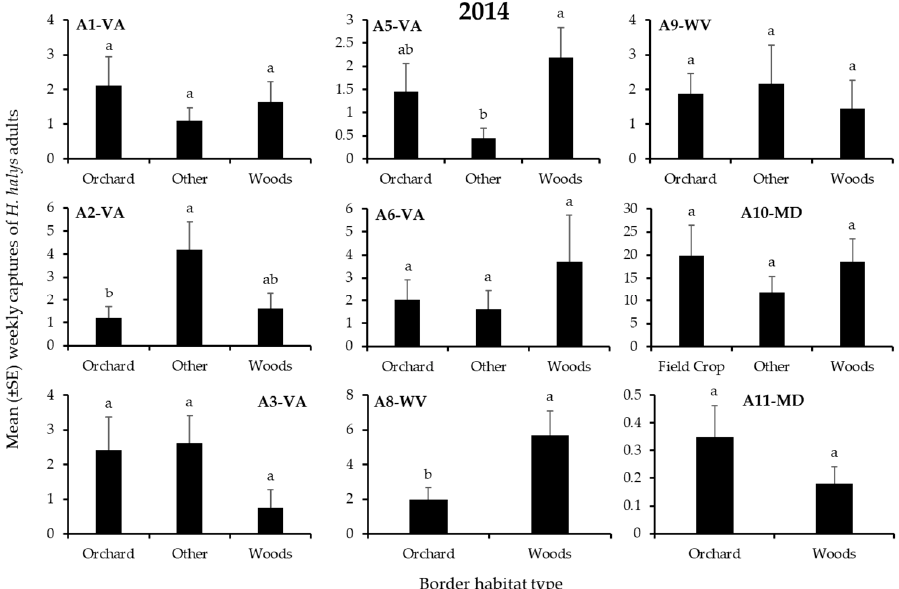
Figure 4. Mean ( ± SE) weekly captures of H. halys ADULTS in pheromone-baited traps on the perimeter of 9 apple orchard blocks in the Mid-Atlantic, USA, from 7 April to 17 October 2014. Bars with shared letters are not significantly different (Tukey HSD, α = 0.05).